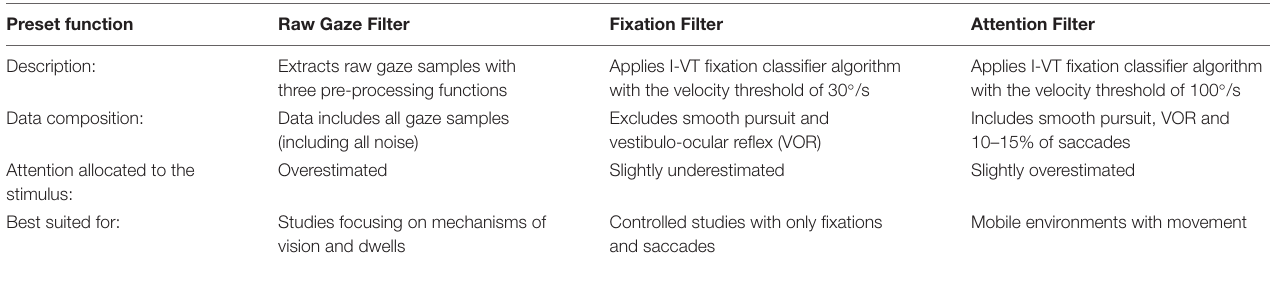
TABLE 1 | The three preset data processing functions of Tobii Pro Lab. Source: adapted from Tobii Technology (2019). Preset function Raw Gaze Filter Fixation